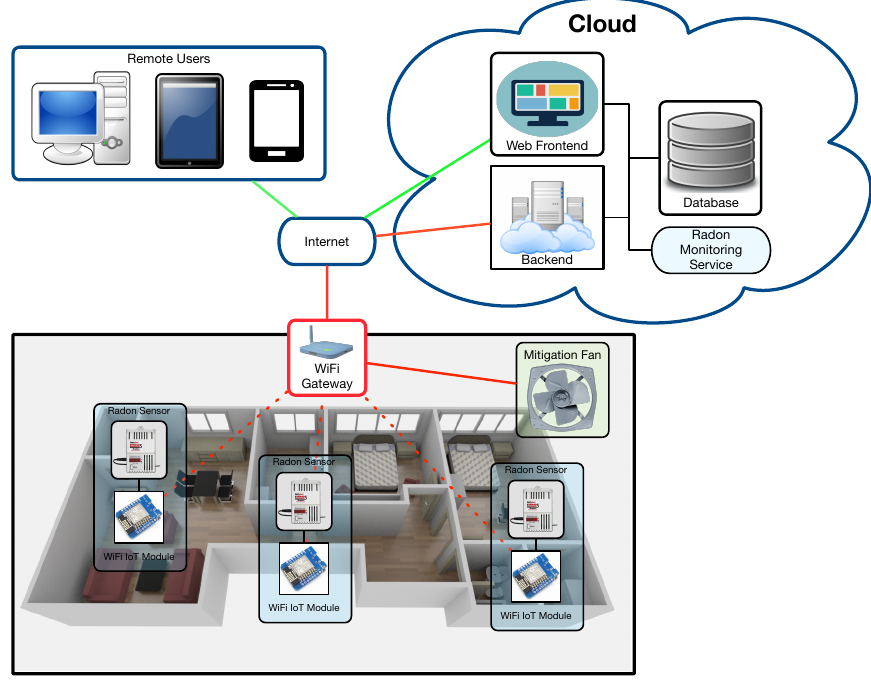
Figure 2. Communications architecture.